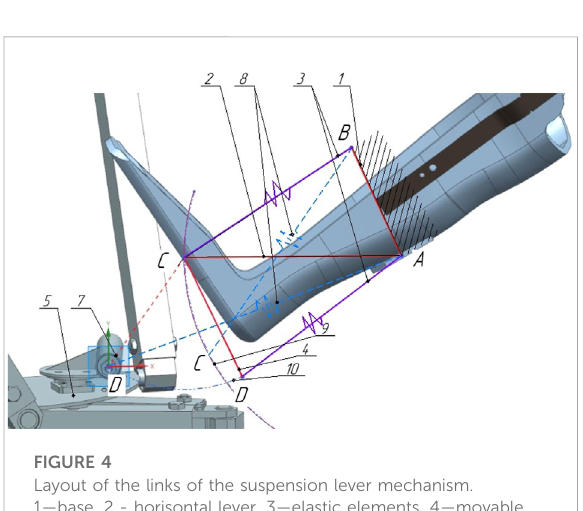
Layout of the links of the suspension lever mechanism. 1 — base, 2 - horisontal lever, 3 — elastic elements, 4 — movable lever, 5 — movable